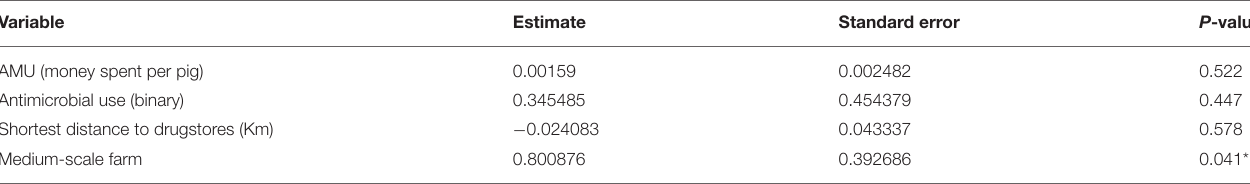
TABLE 2 | LASSO-penalized generalized linear